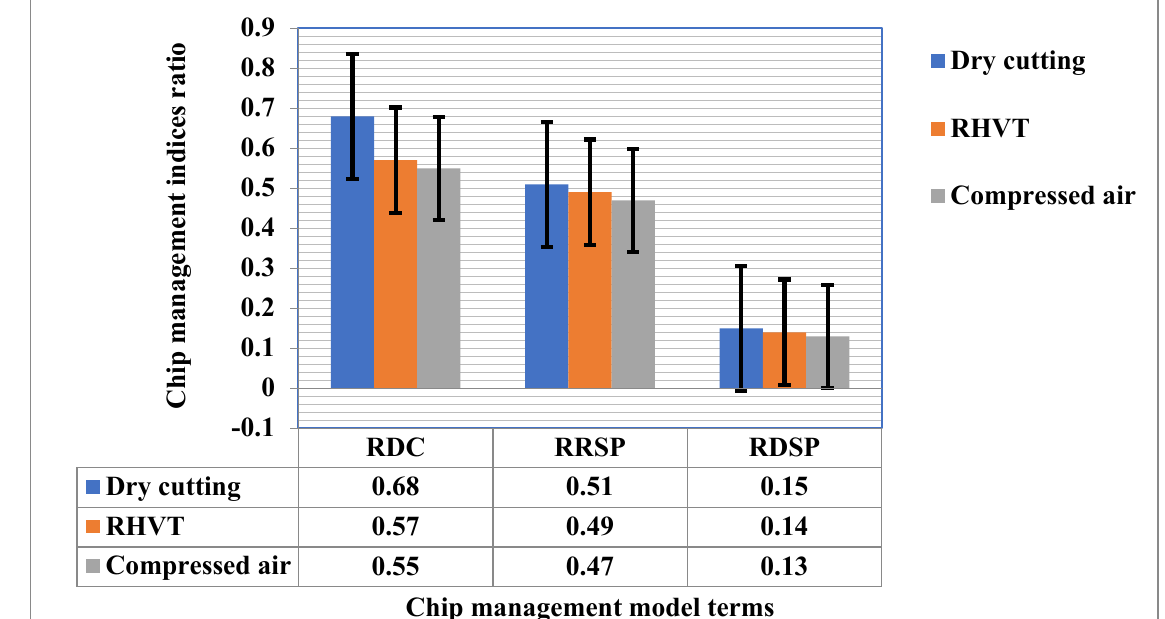
Figure 18. Indices of model based on chip management at different MF conditions.